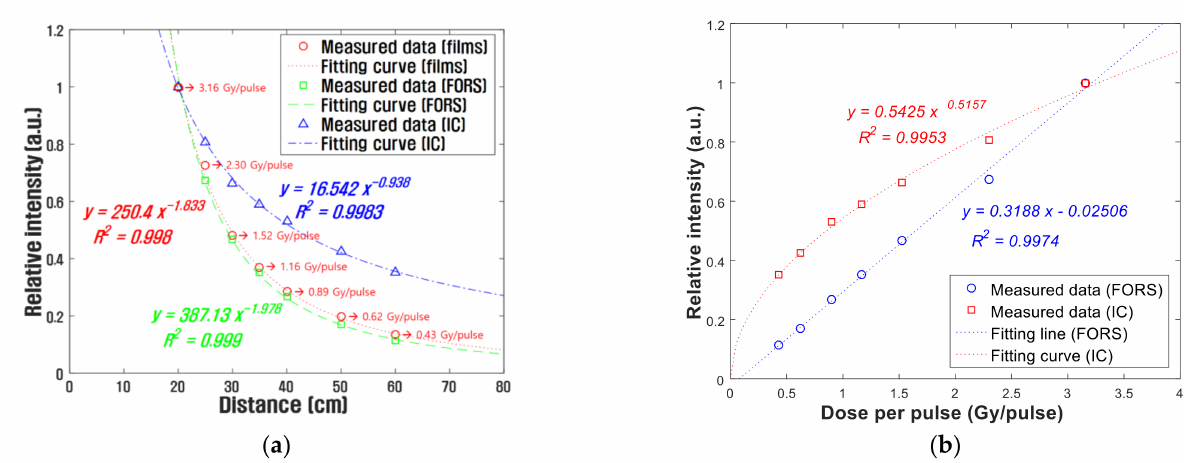
Figure 6. ( a ) Relative outputs of the films, IC, and FORS according to distances from the electron scattering device; ( b ) relative outputs of the FORS and IC according to DPP, as measured using a radiochromic